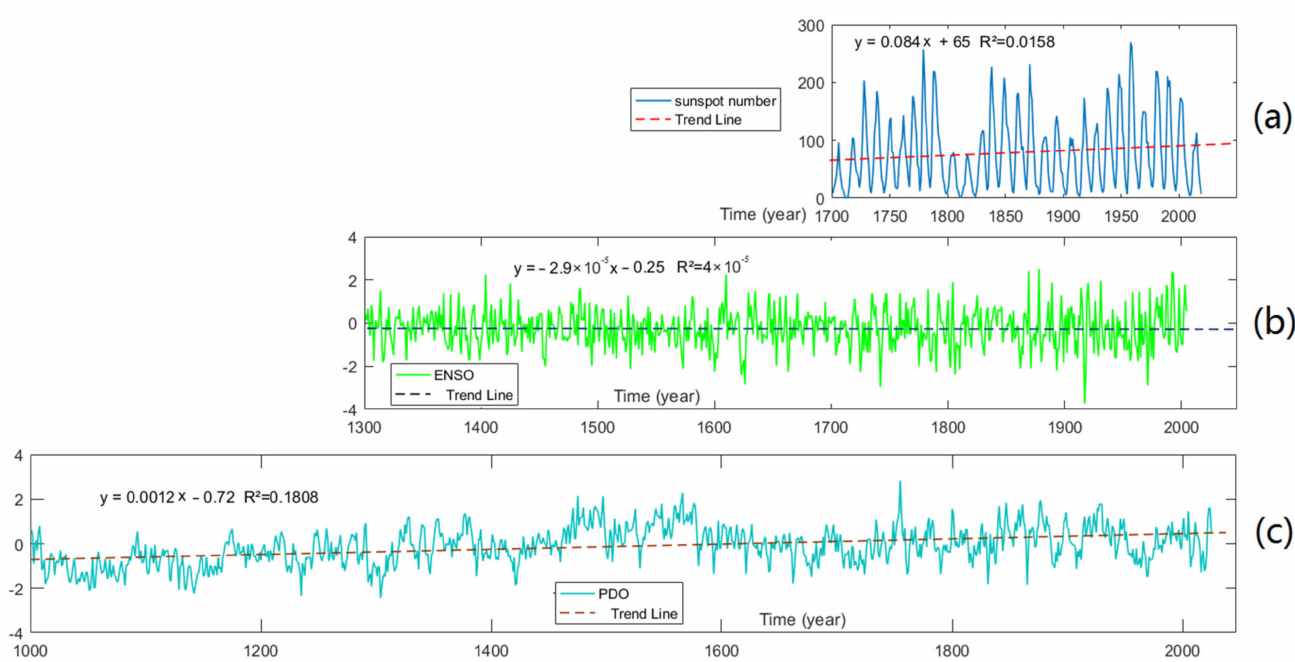
Figure 5. Trend analysis of the three influential factors. The variation trends of ( a ) sunspot number, ( b ) ENSO, and ( c )